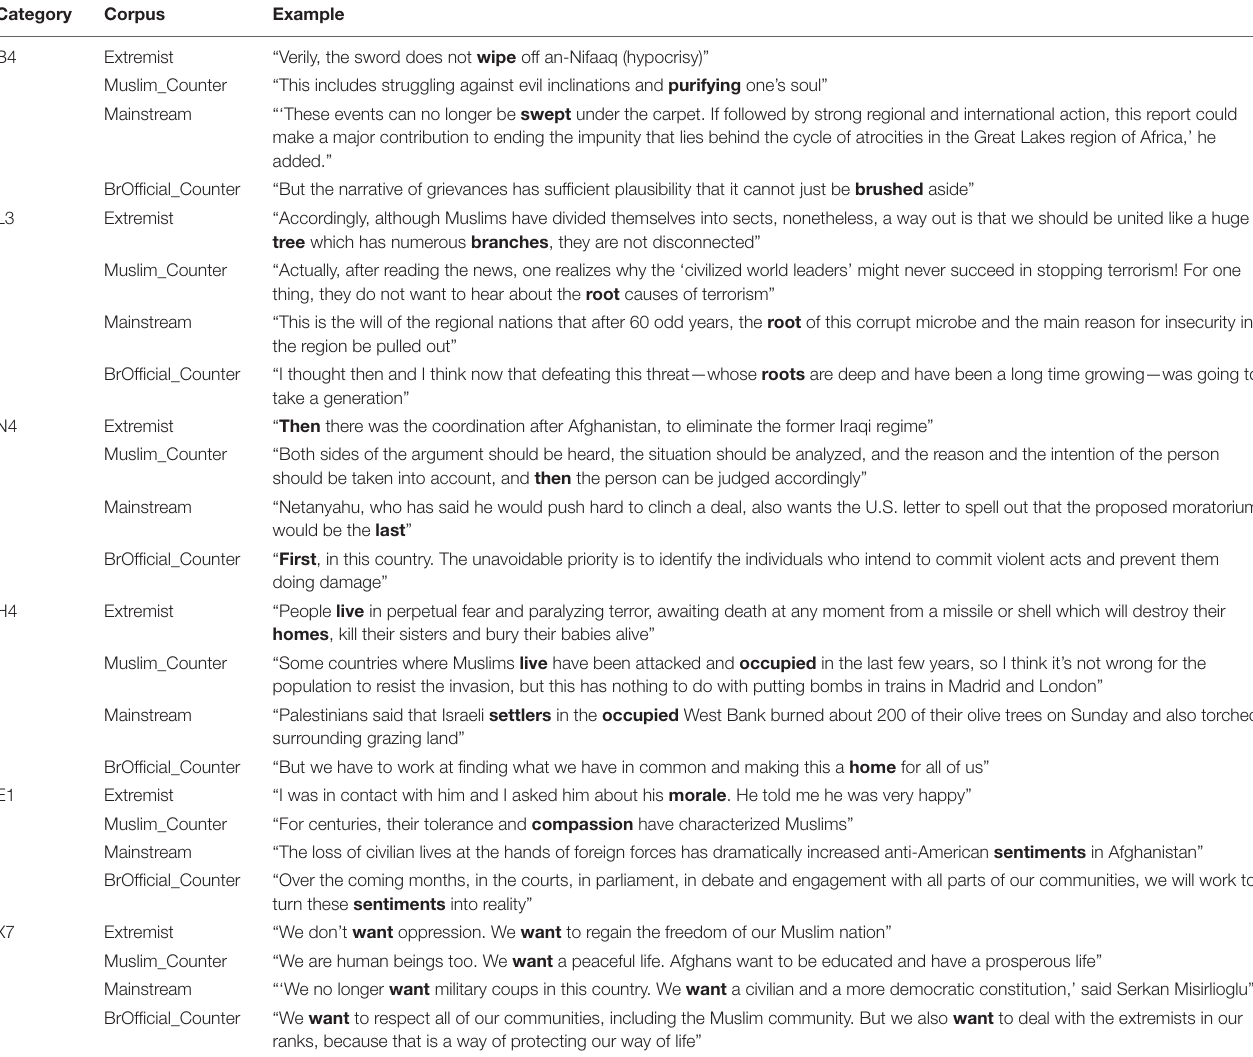
TABLE 1 | Examples of shared conceptual categories between Salafi Jihadist/Related messages (Extremist), religious authored counter-extremist messages (Muslim_Counter), Arab Mainstream Media messages (Mainstream), and British Official counter-extremist messages